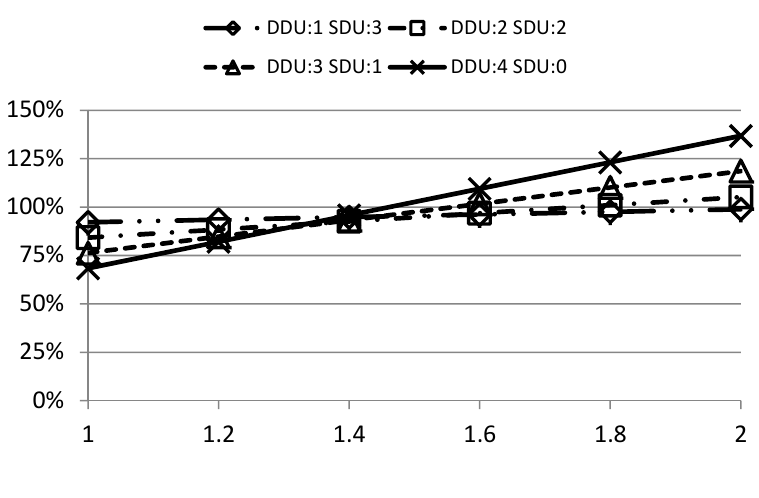
Figure 13. Sensitivity to dynamic power of DDU